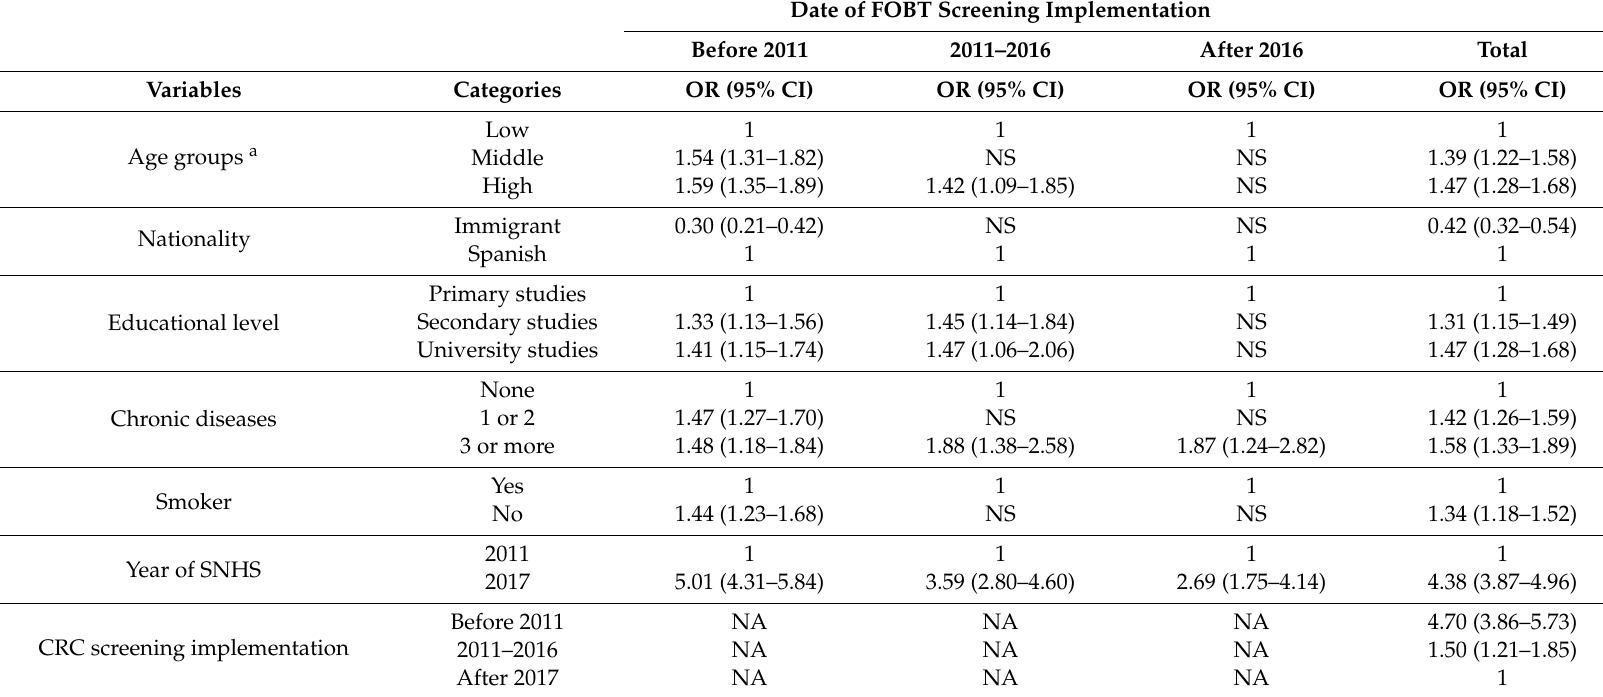
Table 5. Variables independently and significantly associated with fecal occult blood test uptake after multivariable logistic regression analysis according to the date colorectal cancer screening was implemented. Results from the Spanish National Health Surveys 2011 and